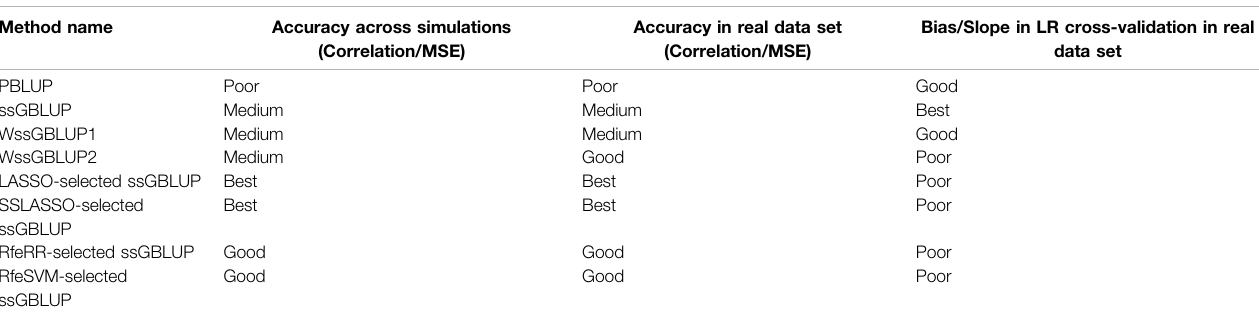
TABLE 4 | Summary of results obtained using the nine models considered in the study and the cross-validations